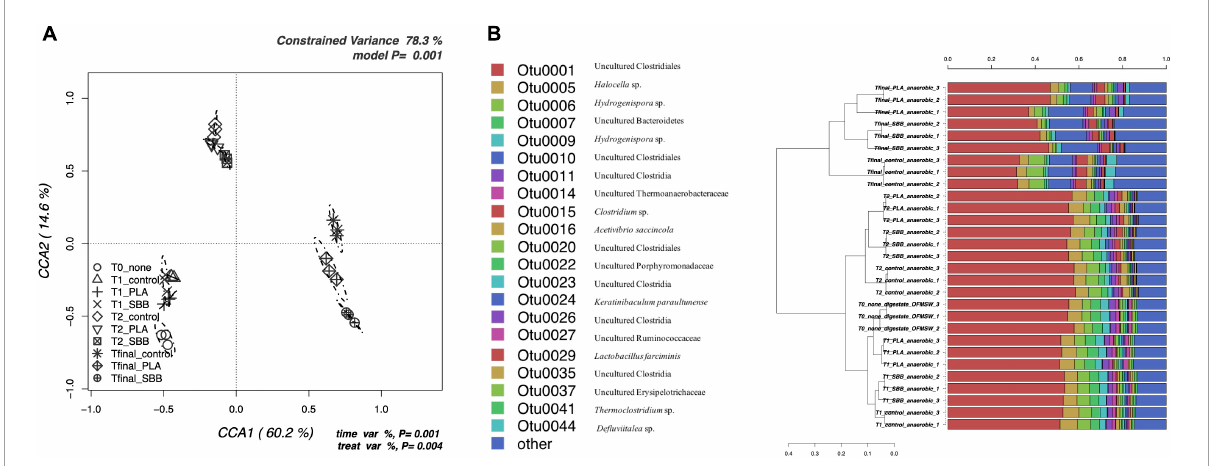
FIGURE5 Bacterial community during anaerobic digestion. (A) Hypothesis-driven canonical correspondence analysis (CCA) model performed on the total bacterial OTUs relative abundance data from anaerobic digestion intermediate samples. (B) Overview and identification of the most abundant OTUs comprising 99% of the bacterial diversity in anaerobic digestion intermediate samples. PLA, polylactic acid; SBB, starch-based bioplastic; OFMSW, organic fraction of municipal solid